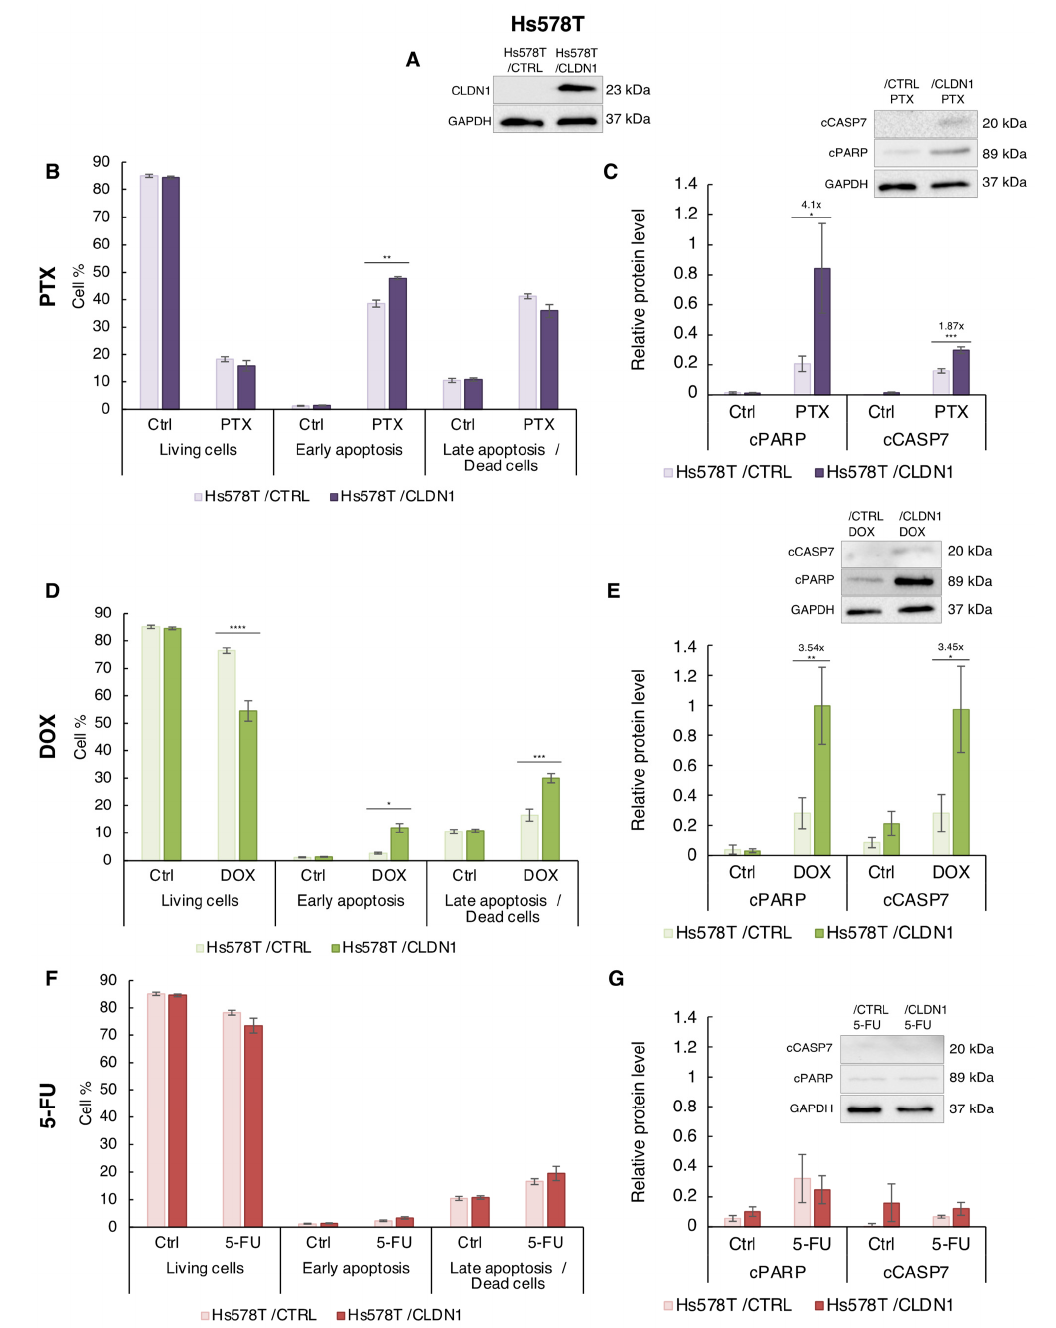
Figure 6. CLDN1 overexpression sensitizes Hs578T cells to PTX and DOX but not to 5-FU. ( A ) Hs578T cells stably transfected with CLDN1 vector (Hs578T/CLDN1) or the empty vector (Hs578T/CTRL) were treated for 72 h with ( B , C ) PTX at 5 nM, ( D , E ) DOX at 210 nM and ( F , G ) 5-FU at 181 µ M, or with solvent (Ctrl). ( A ) CLDN1 expression was studied by western blot. ( B , D , F ) Hs578T cells were co-labeled with annexin V coupled to FITC and with propidium iodide and the living, early- and late-apoptotic cells were analyzed by flow cytometry. ( C , E , G ) Cleavage of apoptotic markers PARP-1 (cPARP) and caspase 7 (cCASP7) expression were analyzed by Western blot. Relative protein level expressions correspond to the protein of interest on GAPDH ratios. The values represent the means ± SEM of three to four different experiments. A p -value of less than 0.05 was considered statistically significant with * p < 0.05, ** p < 0.01, *** p < 0.001, **** p < 0.0001. The uncropped blots are shown in File